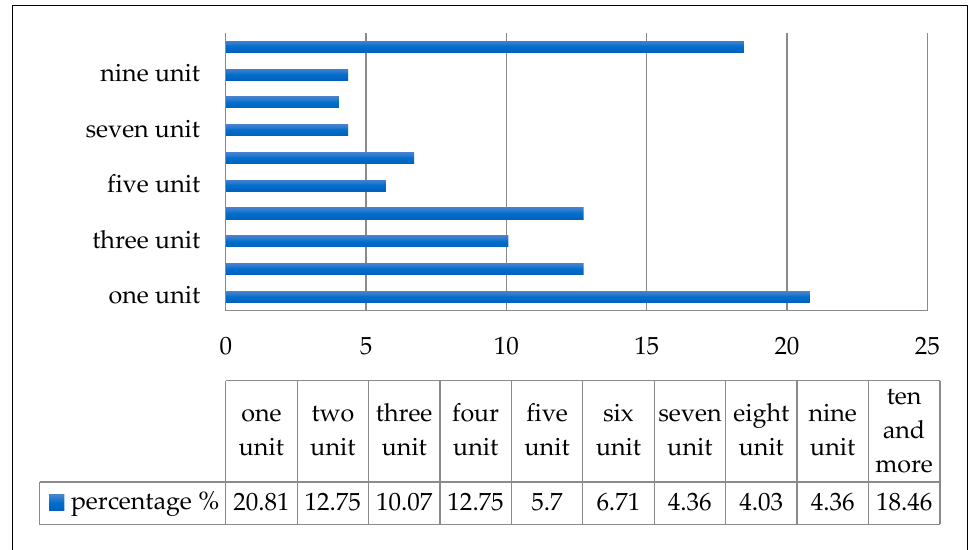
Figure 6. Number of residential units within each building.